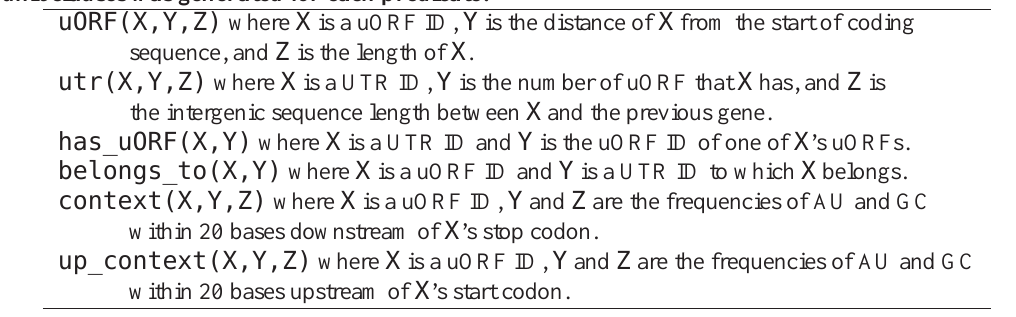
Table 3: Predicates representing background knowledge of uORFs and UTRs. A set of ground unit clauses was generated for each predicate.